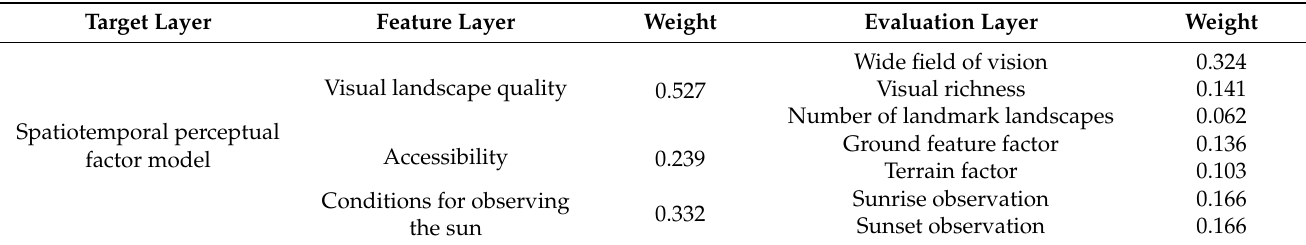
Table 4. Weight coefficient of spatiotemporal perceptual factor